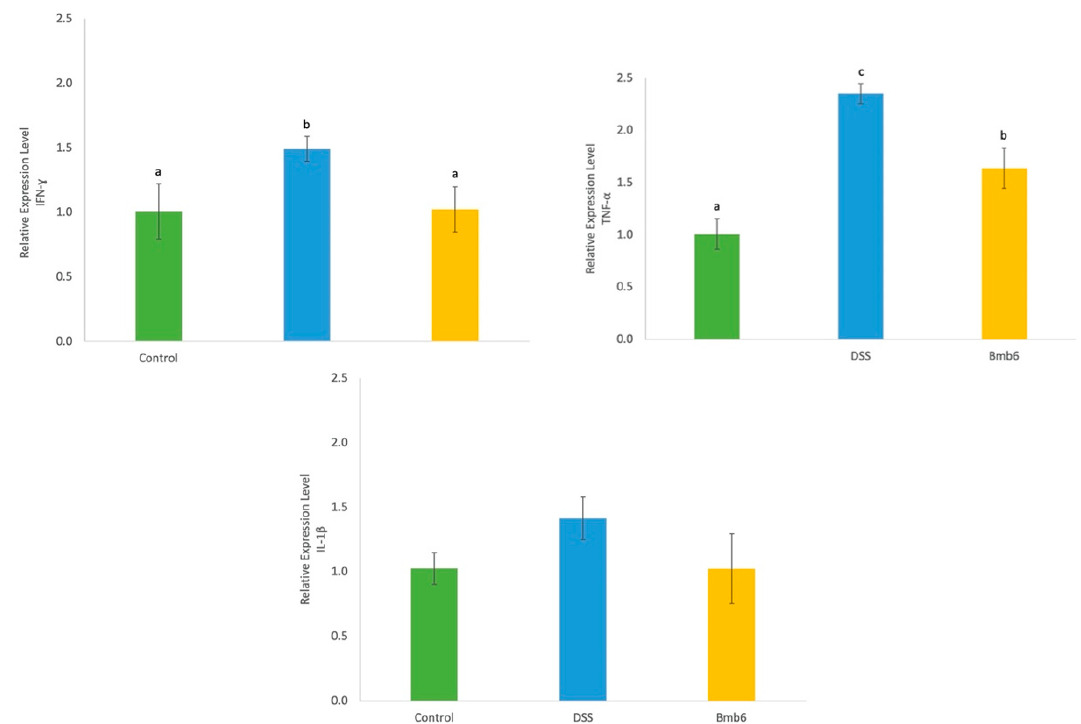
Figure 8. Relative gene expression of inflammatory cytokines (IFN- γ , TNF- α , and IL-1 β ) in the colon of DSS-induced colitis mice. Data represent the mean ± standard deviation ( n = 6 mice per group). Tukey’s multiple comparison test was performed, and different lowercase letters indicate statistically significant differences ( p < 0.05).